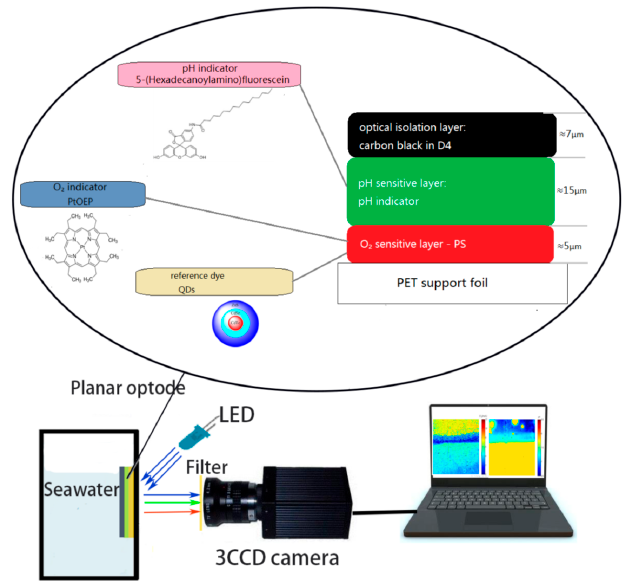
Figure 1. Schematic drawing of the new ratiometric multiple pH/Oxygen planar optode (the oval part) and measuring system with JAI AT-200GE 3CCD camera. The oval part indicates the drawing of the pH/Oxygen sensor composed of a three layer system containing the depicted indictor and reference dyes. Filter: 455 nm longpass. LED: high power LED (peak wavelength 405 nm) as a light source.